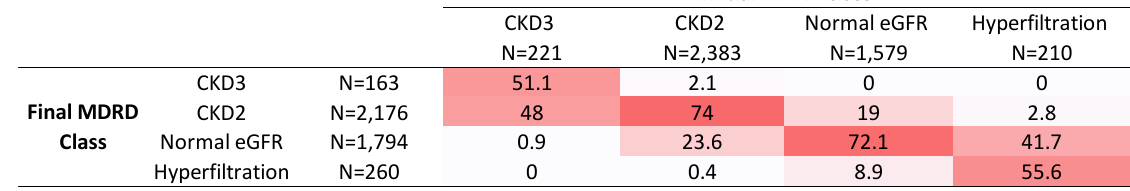
Figure 3. Evolution of MDRD classes over time (%). 3.4. Sensitivity Analyses eGFR was significantly increased during the program for patients with diabetes (86 (71; 100) vs. 87 (74; 103) mL/min/1.73 m 2 , p -value < 0.01) or hypertension (82 (70; 94) vs. 85 (74; 98) mL/min/1.73 m 2 , p -value < 0.01). GFR also increased for normotensive and non- diabetic patients (85 (76; 97) vs. 89 (78; 101) mL/min/1.73 m 2 , p -value < 0.01). By consider- ing patients with two measures only in the weight loss phase of the program, the change was similar to overall results (86 (74; 98) vs. 88 (77; 100) mL/min/1.73 m 2 , p -value < 0.01) (Table 4).